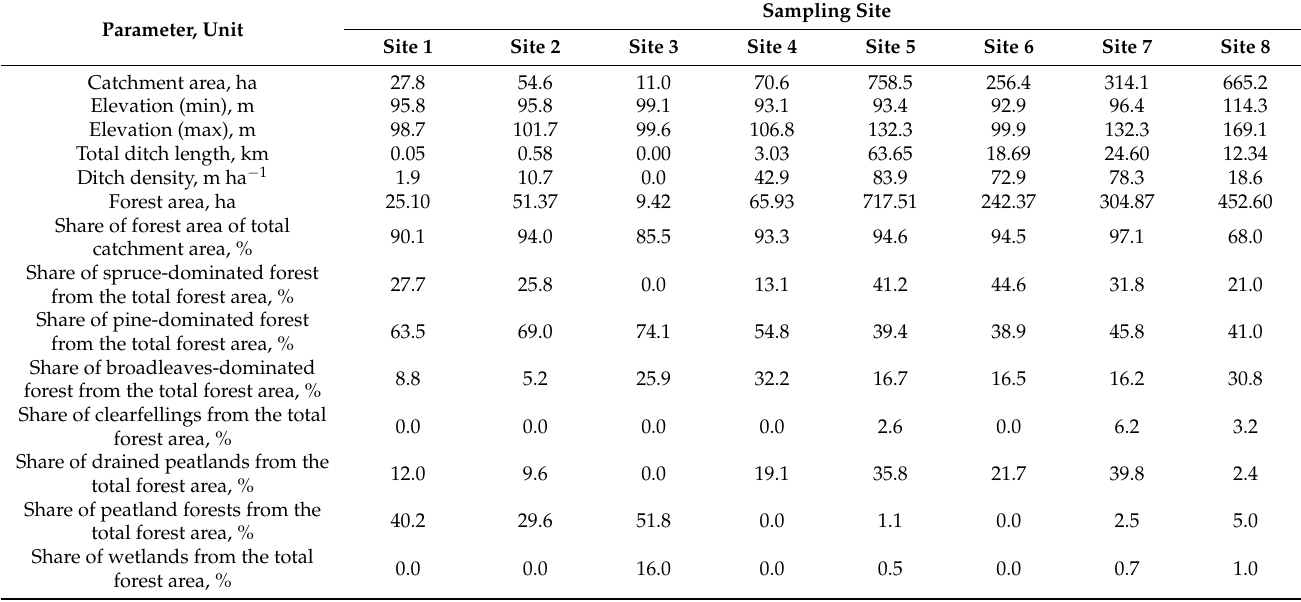
Table A1. Characteristics of drainage system catchments corresponding to each sampling site. Parameter,